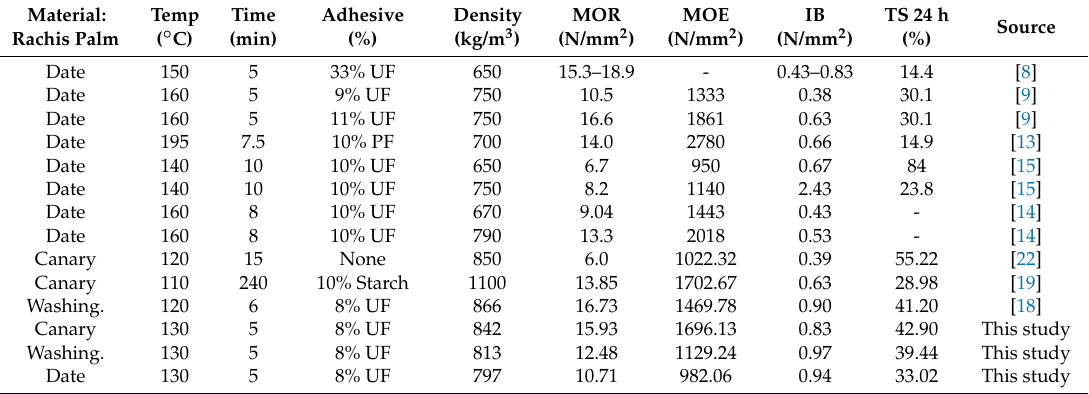
Table 4. Average properties of palm rachis particleboards by different authors.